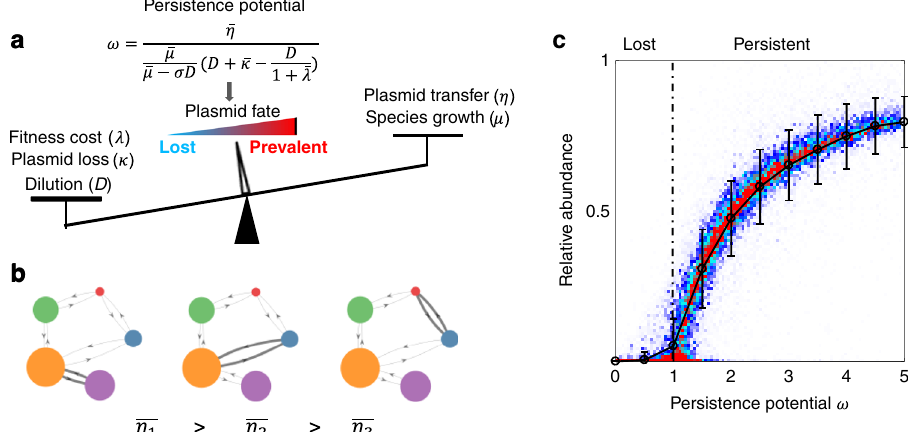
Fig. 3 Persistence potential ω predicts the maintenance and abundance of plasmids. a ω accounts for the contribution from multiple parameters. The plasmid horizontal transfer and population growth promote the ω value, while fi tness cost, plasmid loss, and dilution suppress the ω value. b The weighted average transfer rates ( (cid:2) η ) are calculated with respect to species abundances. A community of fi ve species and one plasmid is illustrated as an example. The arrows represent the horizontal transfer of the plasmid, and the width of the arrow represents the magnitude of the transfer rate. The fi lled circles represent the populations, with their areas corresponding to the abundance. With equivalent conjugation rates, the conjugation pairs with higher donor or recipient abundance contribute more to (cid:2) η . c ω is a predictor of the steady-state abundance of plasmids. 2000 simulations were performed with 5 – 100 species, 1 – 50 plasmids, and randomized parameters in the range of 0.4 ≤ μ ≤ 0.8 h − 1 , 0.001 ≤ D ≤ 0.005 h − 1 , 0 ≤ κ ≤ 0.002 h − 1 , 0 ≤ λ ≤ 0.2, 0 ≤ η ≤ 0.02 h − 1 . All randomized parameters followed uniform distributions in their ranges. For each simulation, the communities were assembled into a random number of niches. Within each niche, species compete with each other. Each simulation was initialized with random abundances of species and plasmids. The steady-state persistence potential ω of each plasmid and its relative abundance in the entire community were then calculated. The ω range was divided into multiple bins with widths of 0.5. The bar plots represent the mean values + / − standard deviations of all the plasmid abundances within each bin. Each bin contains 1334 to 8547 independent